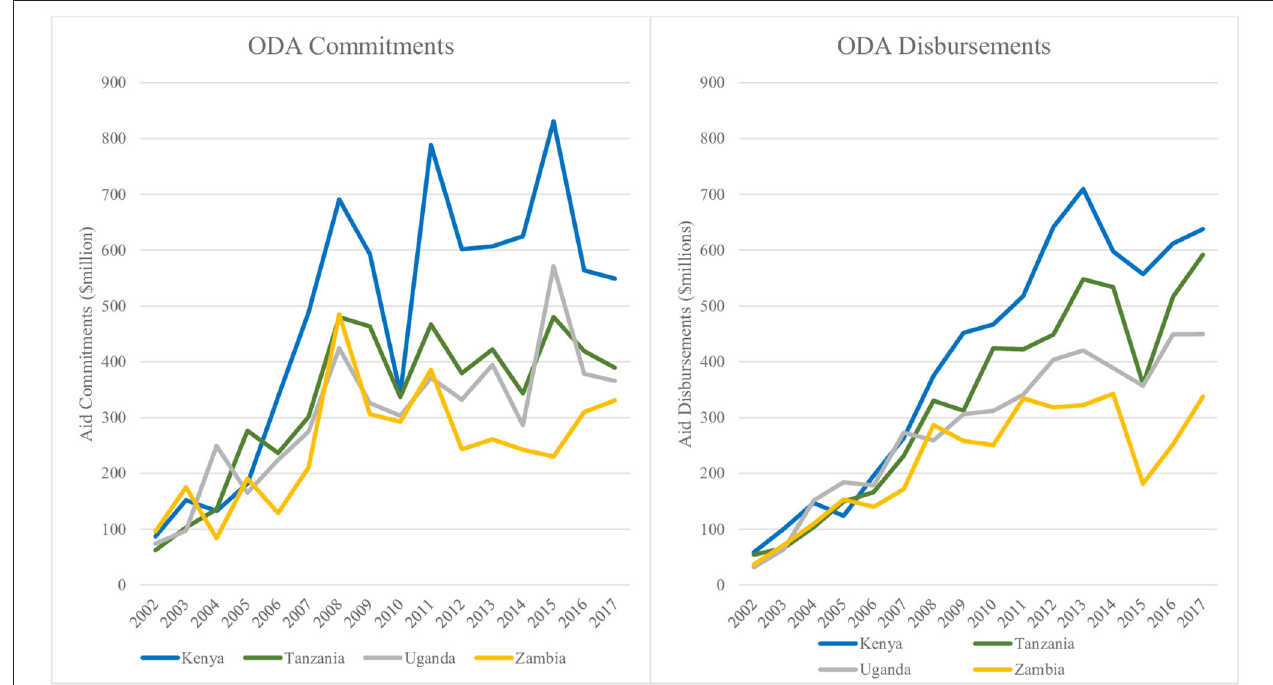
FIGURE 1 | Trends in donor commitments and disbursements for SRH aid to countries 2002–2017 (in USD